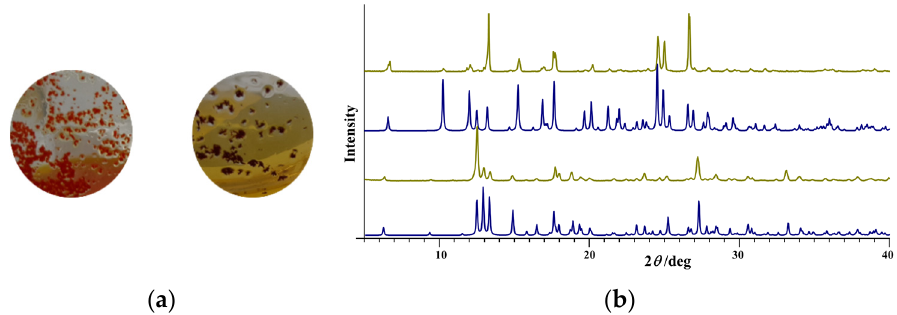
Figure 2. ( a ) Photographs of [1H]Br in MeOH ( left ) and 2Br ꞏ 0.5MeCN in acetonitrile ( right ). ( b ) PXRD patterns of [1H]Br ( top ) and 2Br ꞏ 0.5MeCN ( bottom ). The olive lines indicate patterns obtained by powder diffraction, while the blue lines indicate patterns calculated from the X-ray single-crystal structures of the corresponding compounds.